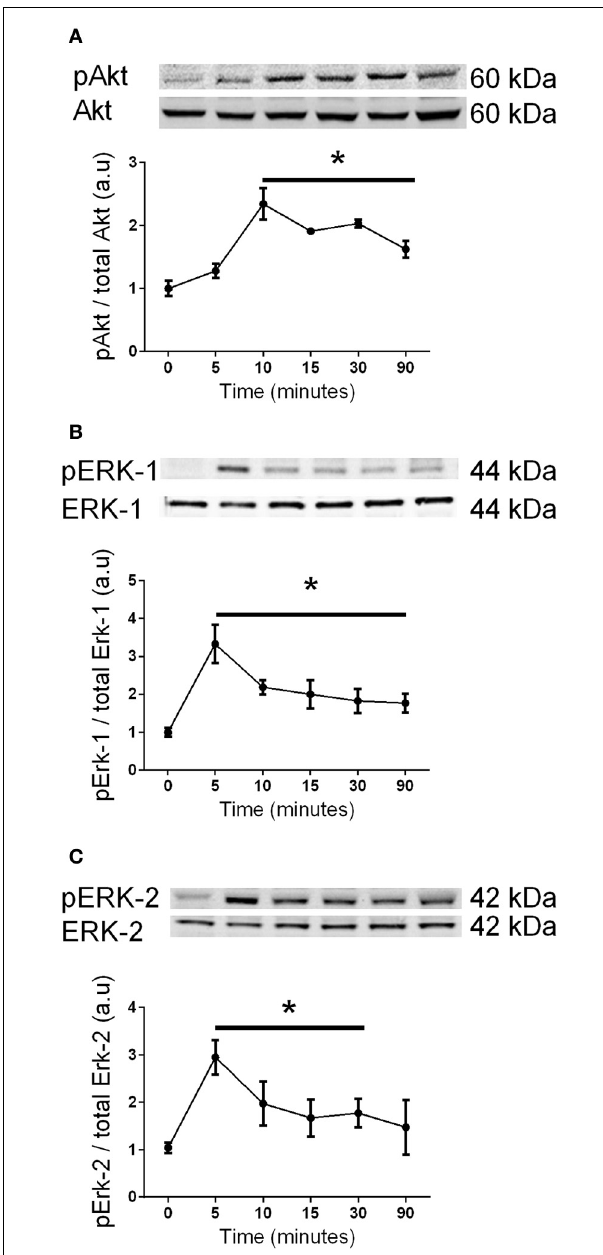
FIGURE 7 | The effects of changing media on Akt and Erk1/2 phosphorylation in C2C12 myoblasts. Western blot analysis using phospho-specific and control antibodies for (A) Akt, (B) Erk-1, and (C) Erk-2 after replenishing the media. Each panel shows a representative western blot above a graph of the fold-change, presented as mean ± SEM compared to time zero ( n = 3, ∗ p < 0 . 05).